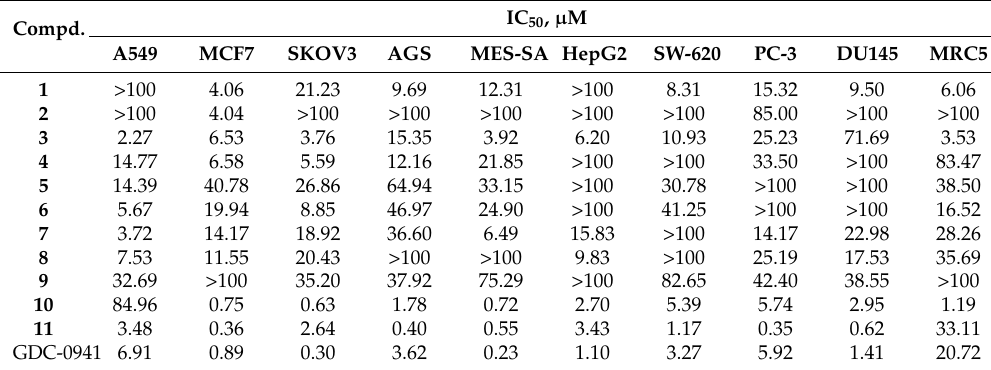
Table 4. Anti-proliferative activities of compounds 1 – 11 and GDC-0941. Compd.